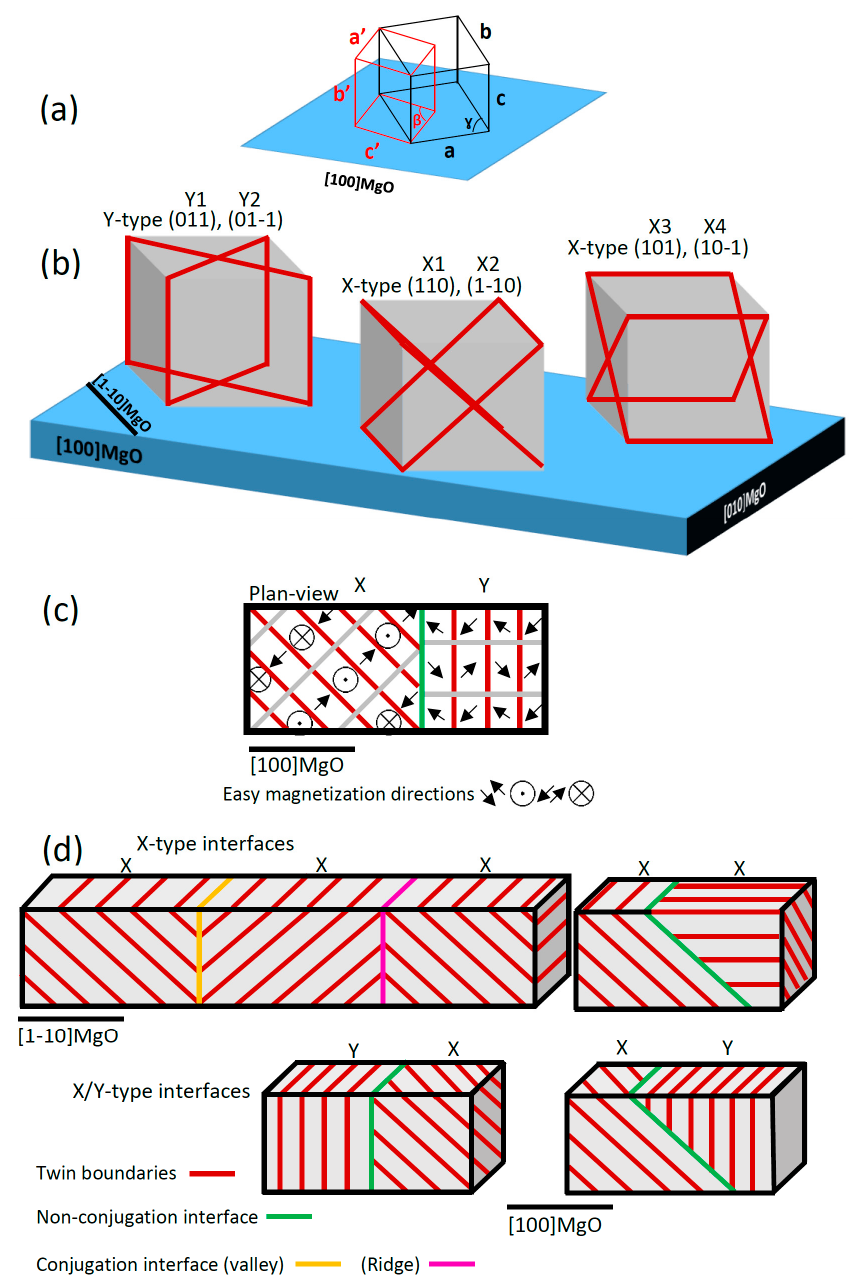
Figure 1. ( a ) Schematic representation of the relative orientations between the standard martensitic (red) and the austenitic setting (black) with respect to the MgO substrate directions. The indices show the three axes of the martensitic cell in the two represented settings. The martensitic seven modulation direction is along c’, whereas it is along one of the < 110 > directions in the austenitic setting. The easy magnetization direction in the two settings is b’ = c. The monoclinic non-right angle is β in the standard setting and γ in the austenitic setting; ( b ) Schematic representation of the {101} cubic planes in the Ni-Mn-Ga austenitic cell that are aligned with the twin boundaries in X-type and Y-type martensitic twin boundaries. ( c ) Top view of the X- and Y-type twin boundaries, showing the orientation of the magnetic easy axis in both the configurations. ( d ) Schematic representation of the martensitic interfaces in X-type and Y-type connecting the colonies of the twin boundaries nucleated from different twinning planes, color version is provided online.